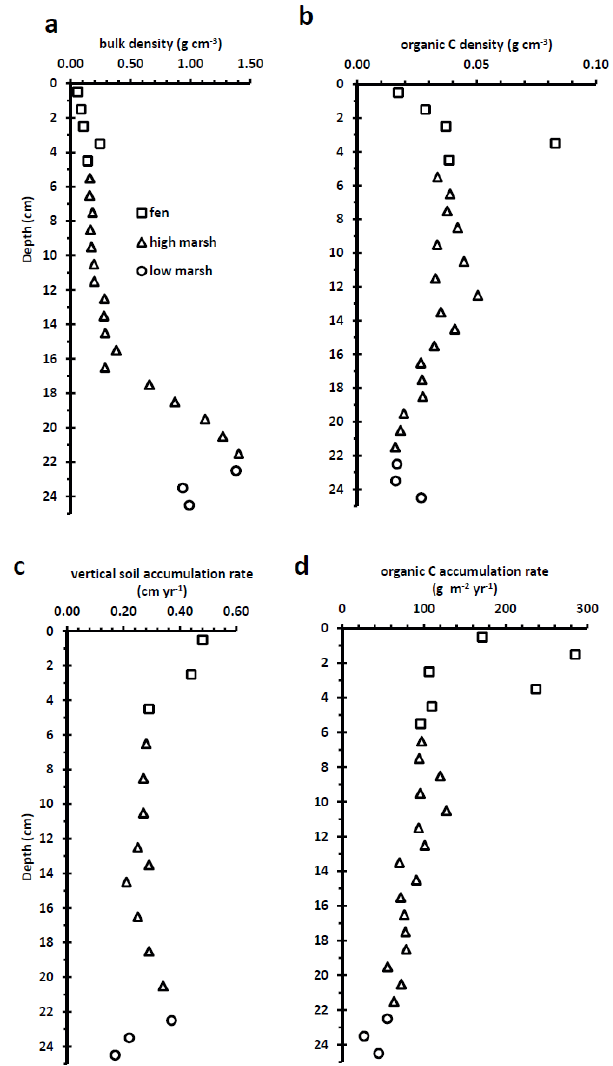
Fig. 3. Profiles of soil bulk density, carbon density, rates of vertical soil accumulation, and rates of C accumulation with depth in wetland deposits of the AMC core from James Bay, Quebec.